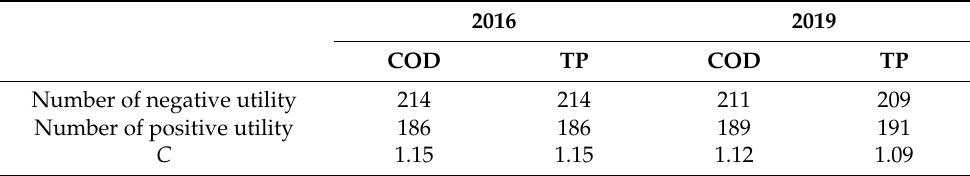
Table 8. Competition index C for water pollutant metabolism network of Fuzhou.